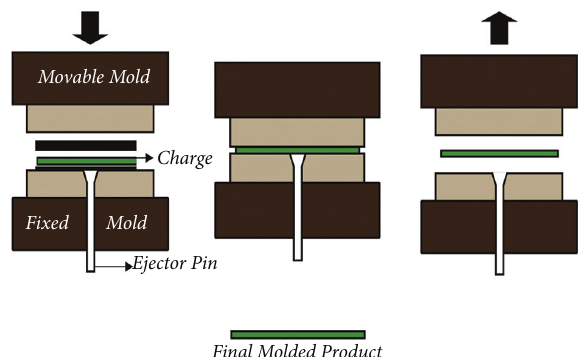
Figure 1: Schematic of compression moulding